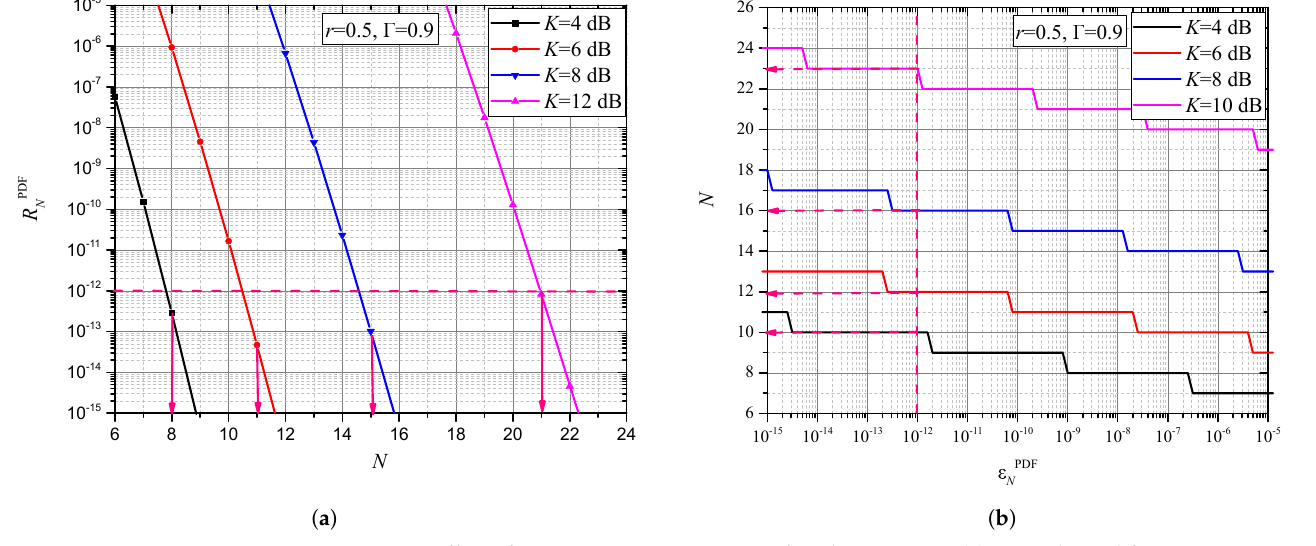
Figure 5. Effect of parameter K on accuracy of evaluating PDF: ( a ) upper bound for truncation error vs. number of terms in summation; ( b ) required number of terms vs. truncation